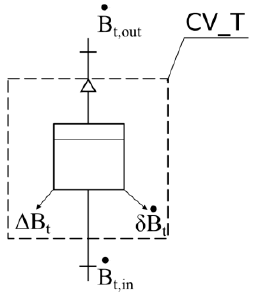
Figure 7. Exergy model for tanks.